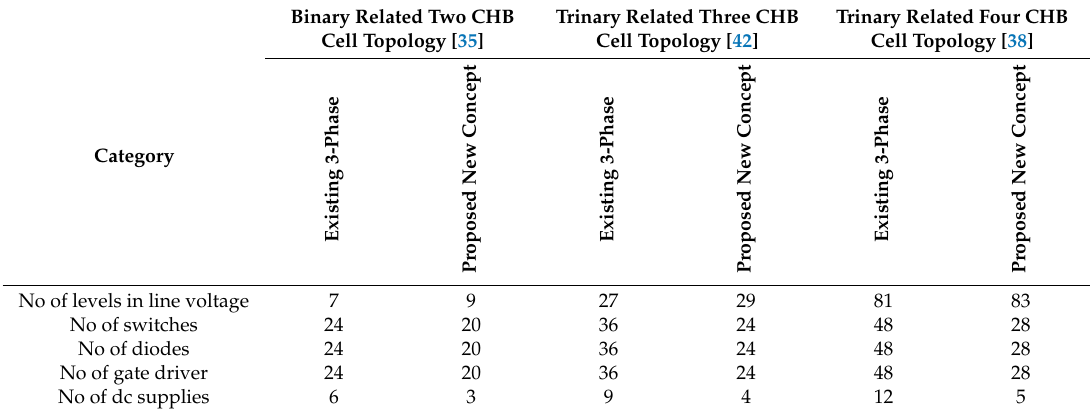
Table 2. Comparison among conventional three-phase CHB topologies and the proposed three-phase cascaded MLI for different asymmetric input voltage arrangements.